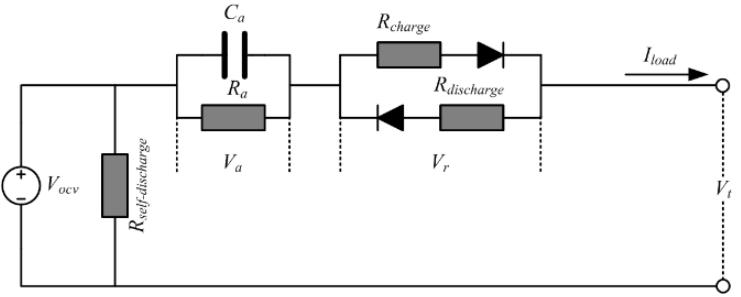
Figure 1. Schematic diagram of first order RC battery model.